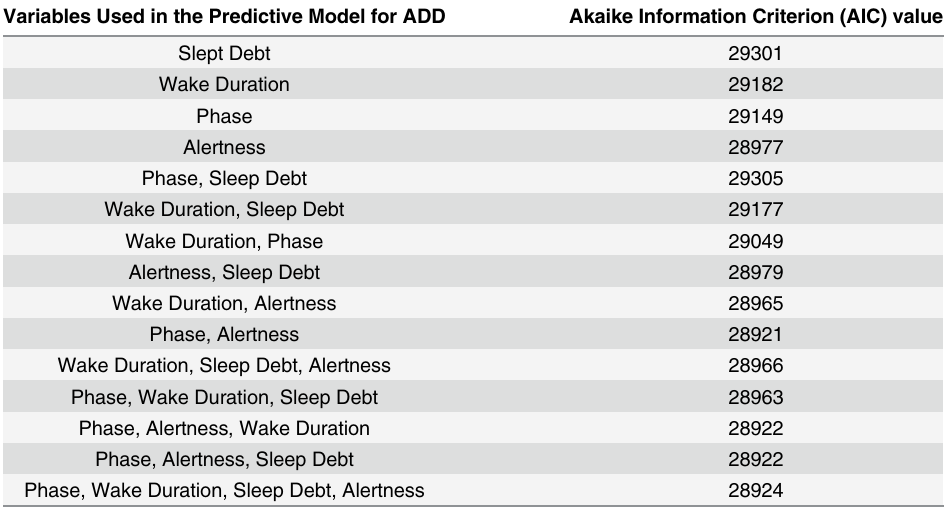
Table 3. Table of Akaike Information Criterion Values (AIC) for different predictive models of ADD. Variables Used in the Predictive Model for ADD